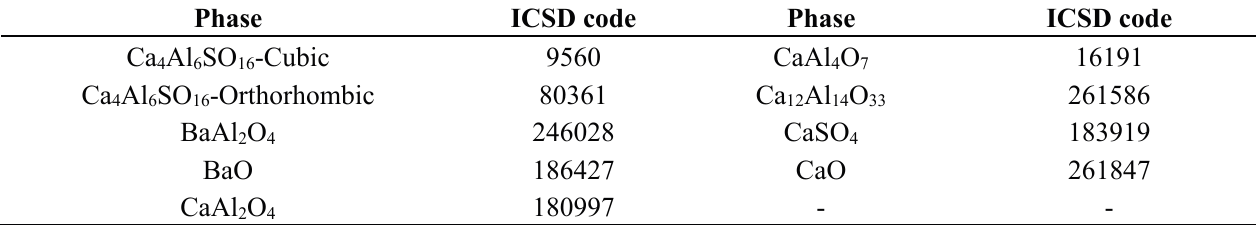
Table 2. Phases and ICSD